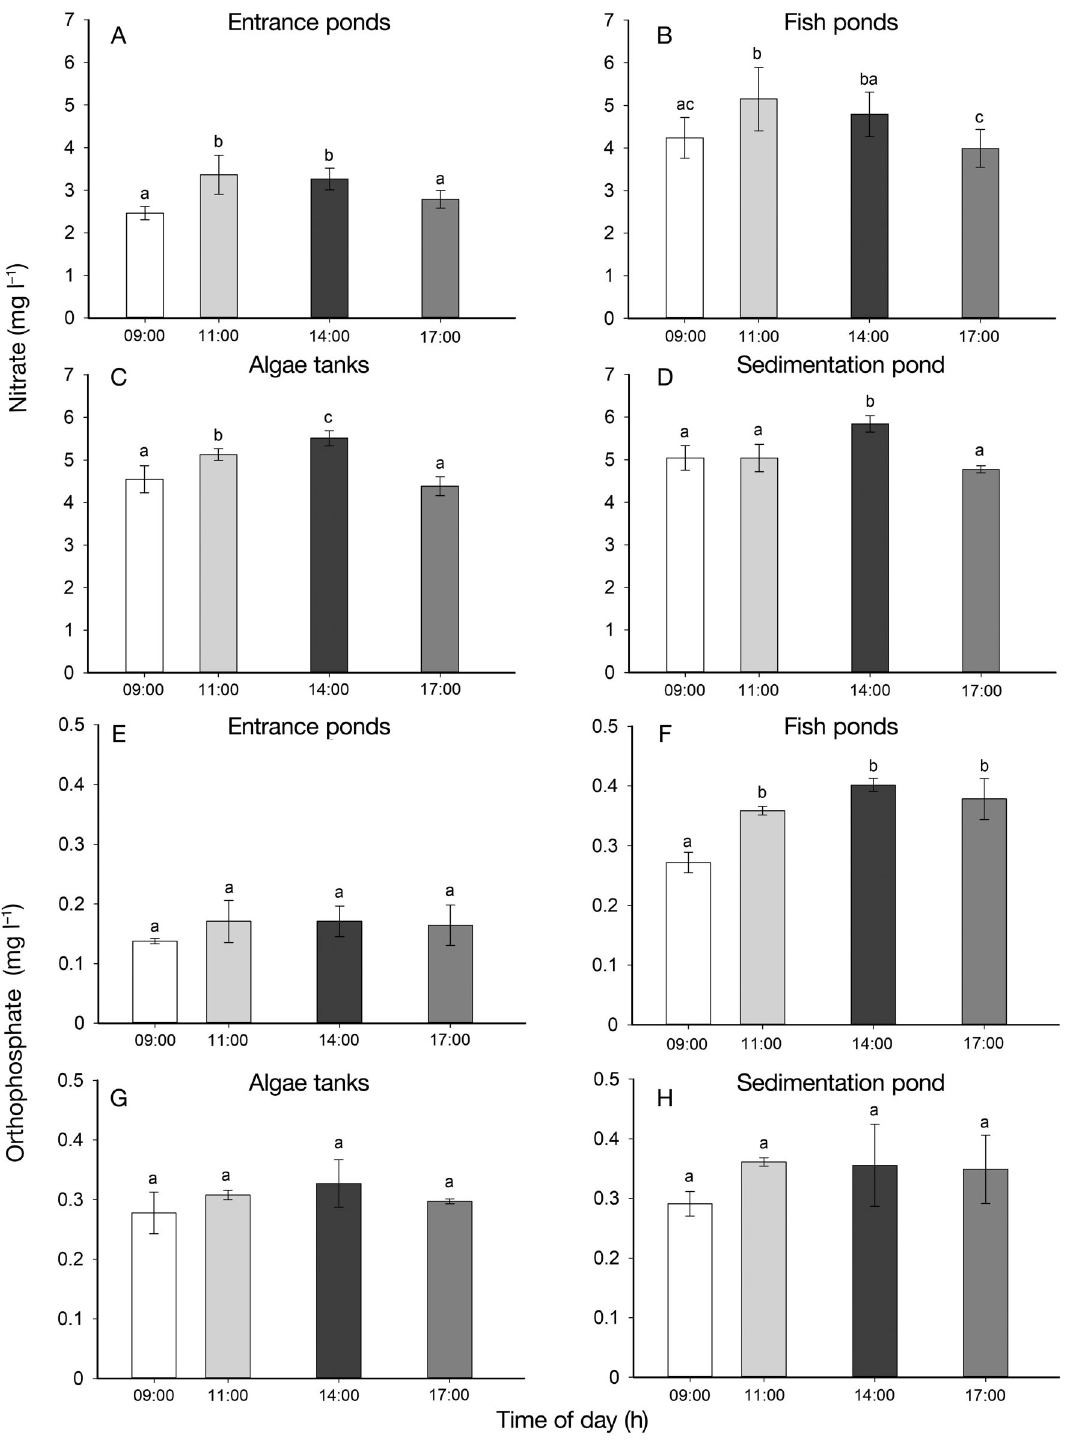
Fig. 5. Comparison of the concentration of nitrate (NO 3− ) and orthophosphate (PO 43− ) along with the sampling site; values dis- play the mean of NO 3− and PO 43− concentrations in (A) entrance ponds 1 and 2, (B) fish ponds 1, 2, 3 and 4, (C) after filtration of the water, and in (D) algae tanks. Average of PO 43− concentrations in (E) entrance ponds 1 and 2, (F) fish ponds 1, 2, 3 and 4, (G) algal tanks and (H) sediment pond. A 1-way ANOVA was performed to reveal statistically significant differences, followed by Tukey’s post hoc comparisons tests. Groups which do not share the same letter are significantly different (p £ 0.05). Error bars: confidence intervals (p = 0.95; n =